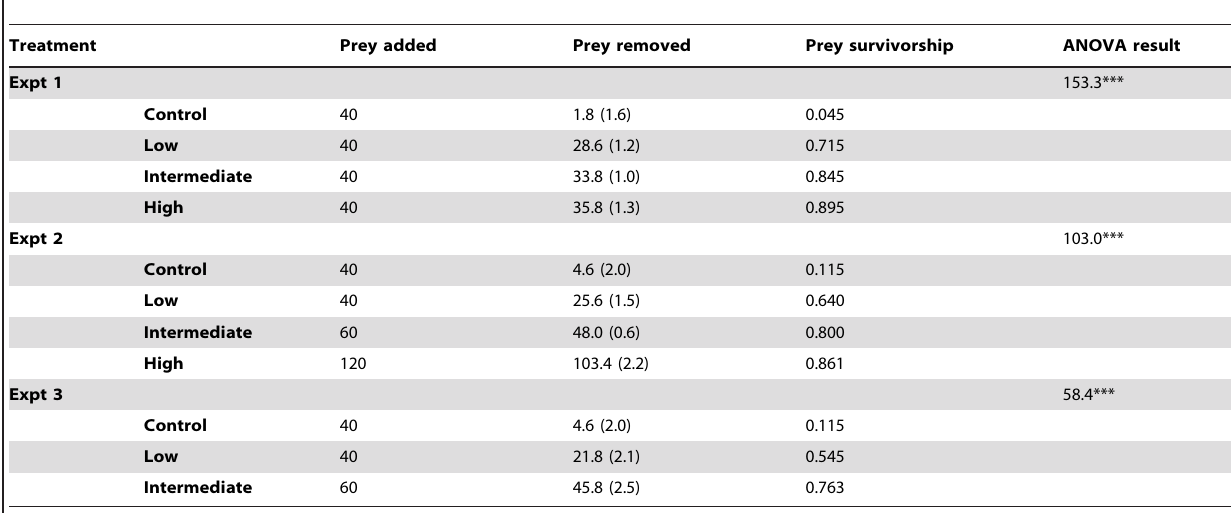
Table 2. Results from each experiment showing the number of prey added (ind), mean number of prey removed (ind 6 1 standard error), mean prey survivorship, and two-way ANOVA results